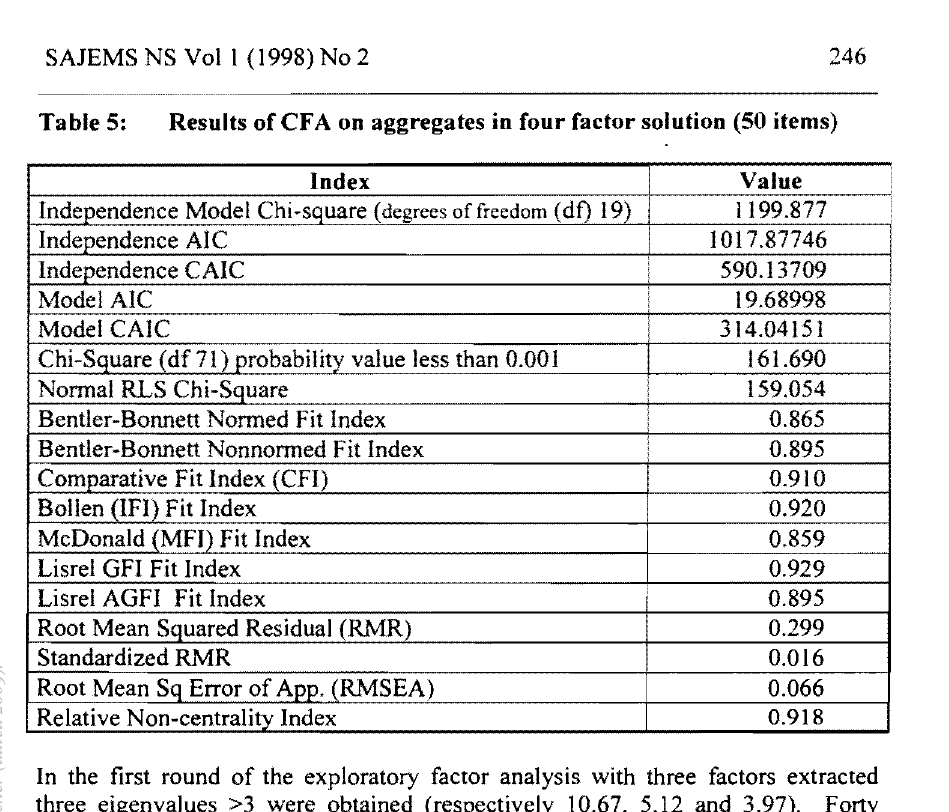
Results of CFA on aggregates in four factor solution (50